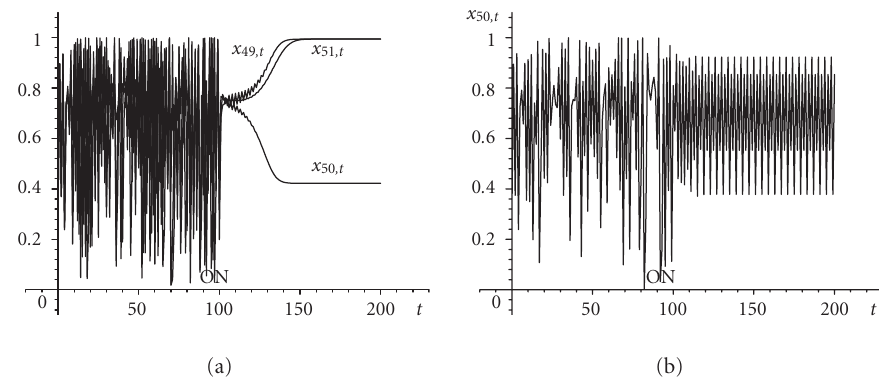
Figure 6.3. Simulations for a strongly coupled map lattice system ( (cid:1) 2 = 4 / 5 > (cid:1) ∗ ): (a) (cid:1) = 4 / 5, γ = 0 . 35, (b) (cid:1) = 4 / 5, γ = 0 . 15. The adaptive adjustment is trigged at 101th step. Initial states are given randomly around 0 .